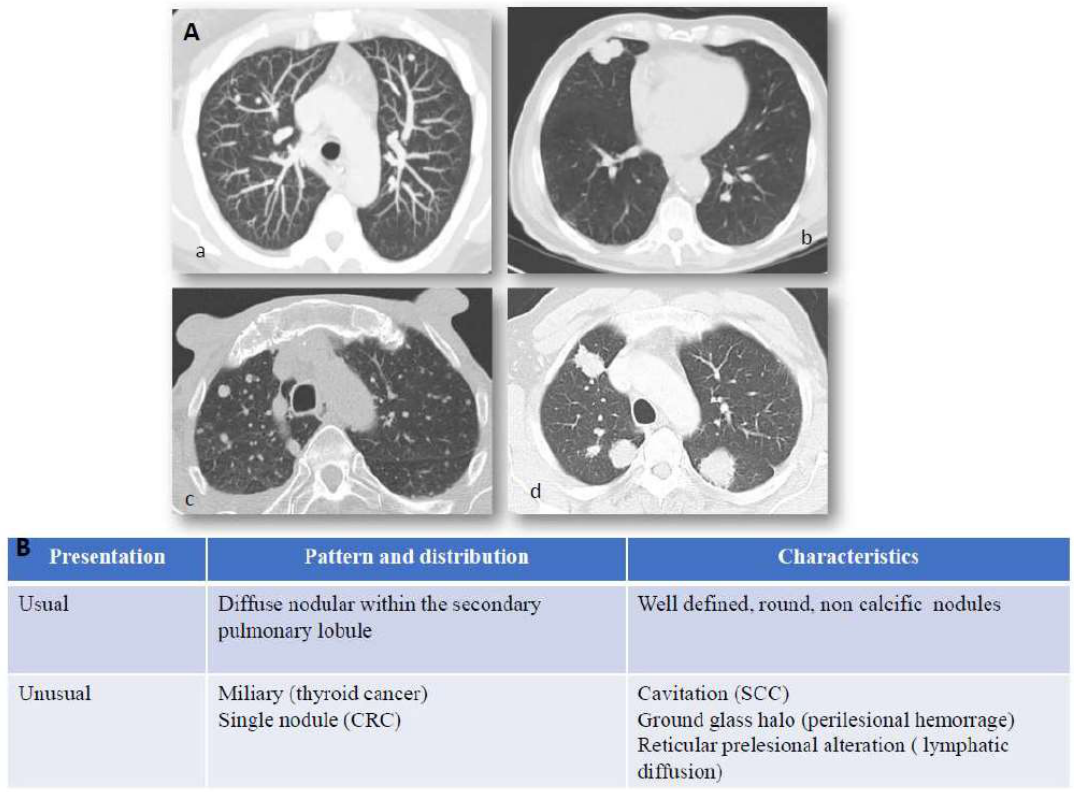
Figure 1. Lung metastases: imaging and immunostaining. In patients with known primary tumors, the appearance of multiple bilateral pulmonary nodules is highly suggestive of metastatic dissemination and no further invasive procedures are generally required to confirm diagnosis. Chest X-Ray (CXR) has shown little sensitivity over the years, relegating it to marginal use in low-risk patients or to be abandoned entirely as a surveillance method. While lung metastases can still be detected by CXR in specific scenarios, such as incidental findings in the emergency room, computed tomography is the main imaging modality employed for detection and follow-up of lung metastases. Panel ( A ) CT scan presentation of lung metastases: ( a ) usual features of lung metastases from colorectal cancer, ( b ) squamous cell lung cancer of unknown primary (CUP), ( c ) miliary distribution of secondary lesion from ovarian cancer, ( d ) multiple metastatic nodules from breast cancer. Hematogenous spread to the lungs most often characterizes those tumors which arise in organs with anatomical venous drainage towards the lungs, such as head and neck, thyroid, adrenals, kidneys, testes, melanoma, and osteosarcoma. Panel ( B ) Computed tomography (CT) presentation of lung metastases. Computed tomography is the main imaging modality employed for detection and follow-up of lung metastases. They generally appear as round and non-calcific nodules of variable dimensions, with smooth margins and a variable degree of vascularization. However, more unusual patterns can be detected as well (such as a miliary distribution or metastatization in the form of a single lung nodule). CRC = colorectal cancer, SCC = squamous cell carcinoma, CUP = Cancer of unknown primary .